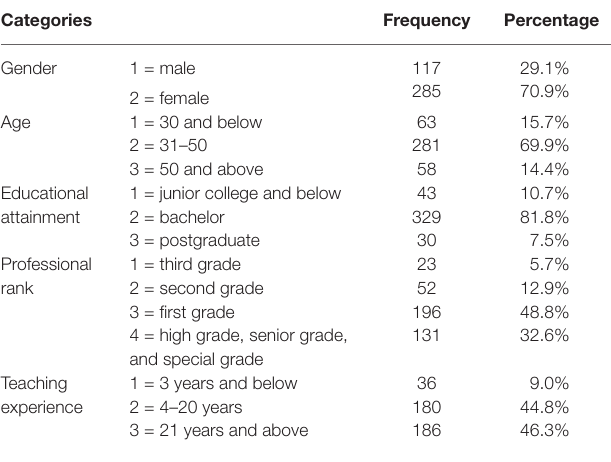
TABLE 1 | Demographic profile of the